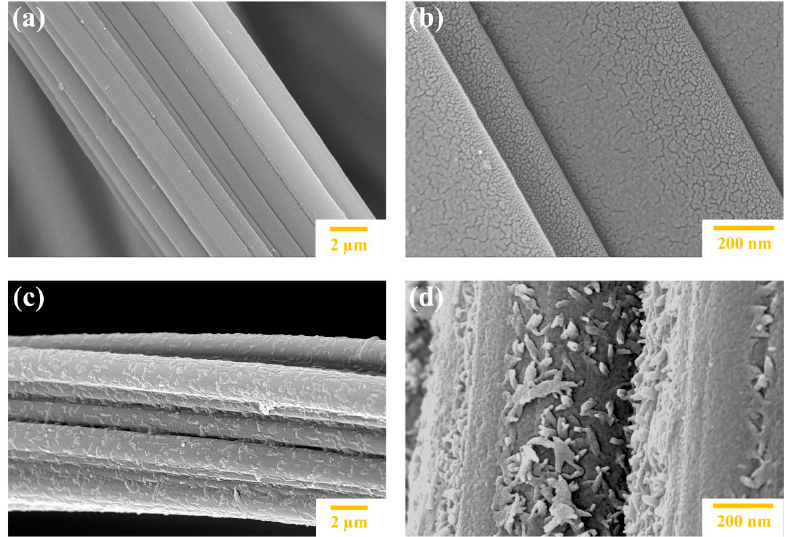
Figure 1. SEM images of activated carbon fiber (ACF) at 5000× ( a ) and 45,000× ( b ) magnification,